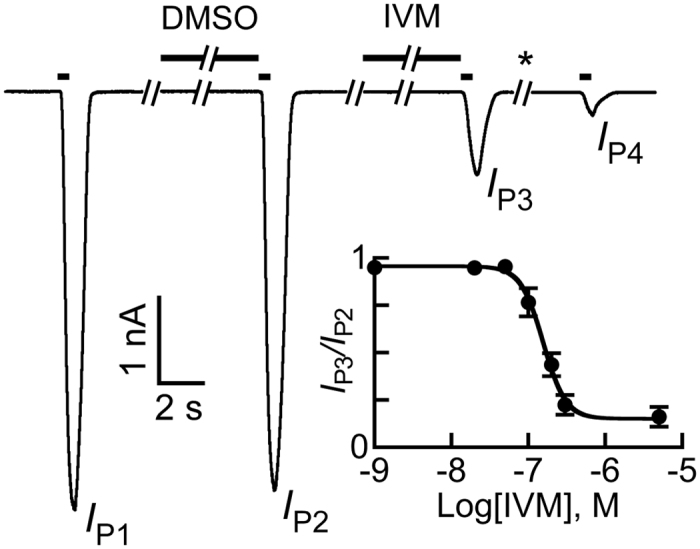
Inhibitory effect of IVM pre-application on the response of the α7-GluClβR to ACh.Following the first ACh application, which gave peak IP1, the cell was washed with a physiological solution for 40 sec. Then, as a control, 0.01% DMSO was applied for 10 sec prior to the second ACh application that gave peak IP2. Next, following a 40-sec-long wash, 5 μM IVM (in the presence of 0.01% DMSO) was applied for 10 sec before its replacement by ACh (giving peak IP3). Finally, following a 2-min-long wash (*), ACh was applied again (giving peak IP4). In all applications, 50 μM ACh was applied for 0.5 seconds. Inset, a curve corresponding to the inhibition of ACh (50 μM)-elicited currents by increasing concentrations of IVM. Data were extracted from experiments performed as in panel A. Since the currents could not be recovered following an exposure to IVM, each cell was exposed only to one concentration of IVM. Then, to provide the normalized ACh response, the peak current recorded in response to ACh immediately after IVM application (i.e., IP3) was divided by the peak current recorded in response to ACh immediately after DMSO application (i.e., IP2). The curve was fitted to the averaged data points with a non-linear regression using the Hill equation 2 (Eq. 2; r2 = 0.996). Error bars correspond to SEM. Total of 41 cells were used to obtain the averaged points. Recordings were performed at −60 mV.